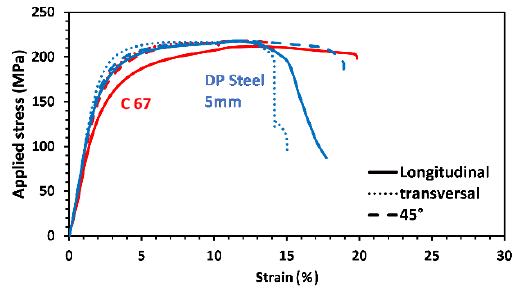
Figure 8. Bending curves of DP steel and C67 samples; each curve represents a different metallurgical orientation.